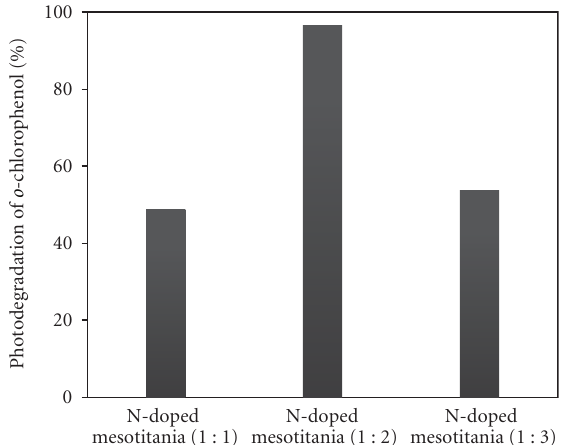
Figure 2: Comparison of the percentage degradation of o- chlorophenol by N-doped mesoporous titania (1:1), N-doped mesoporous titania (1:2) and N-doped mesoporous titania (1:3).